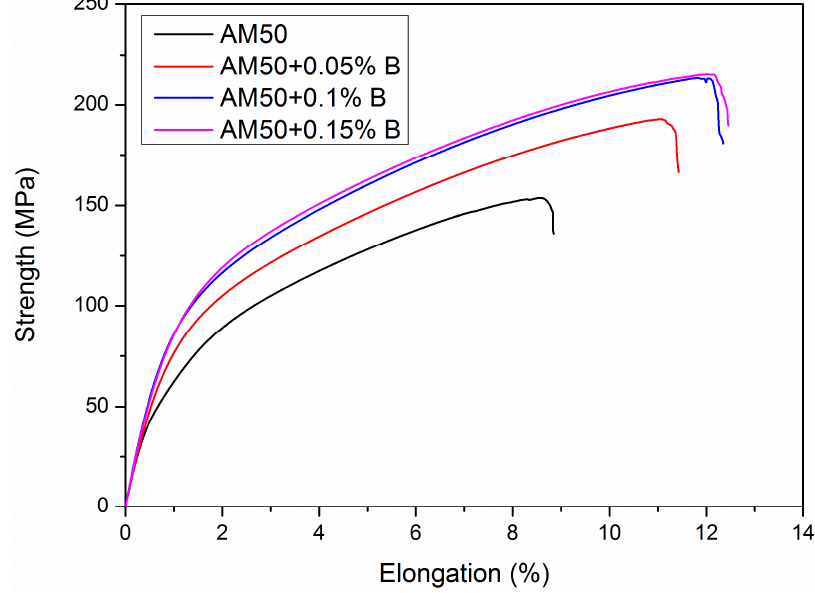
Figure 4. Stress-strain curves for the AM50+B specimens tested at room temperature.